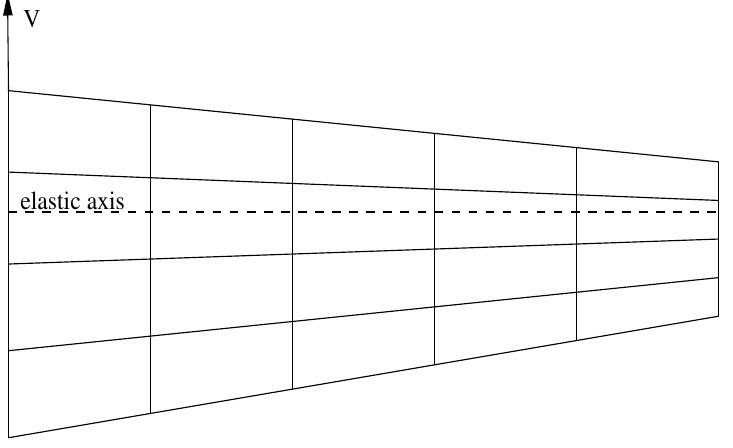
Figure 1. HA145B planform, elastic axis (dashed line), and doublet-lattice